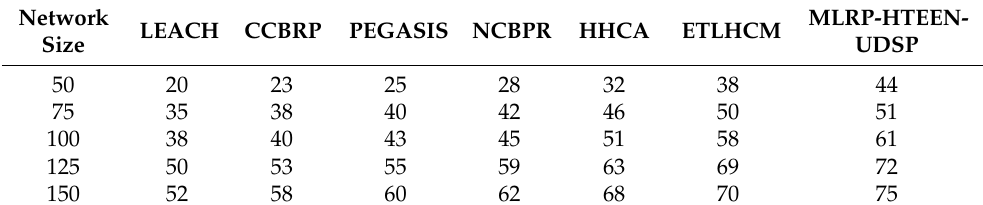
Table 4. Comparison of energy efficiency.